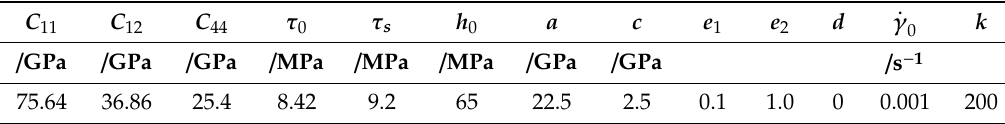
Table 2. The material constants of single crystal aluminum.